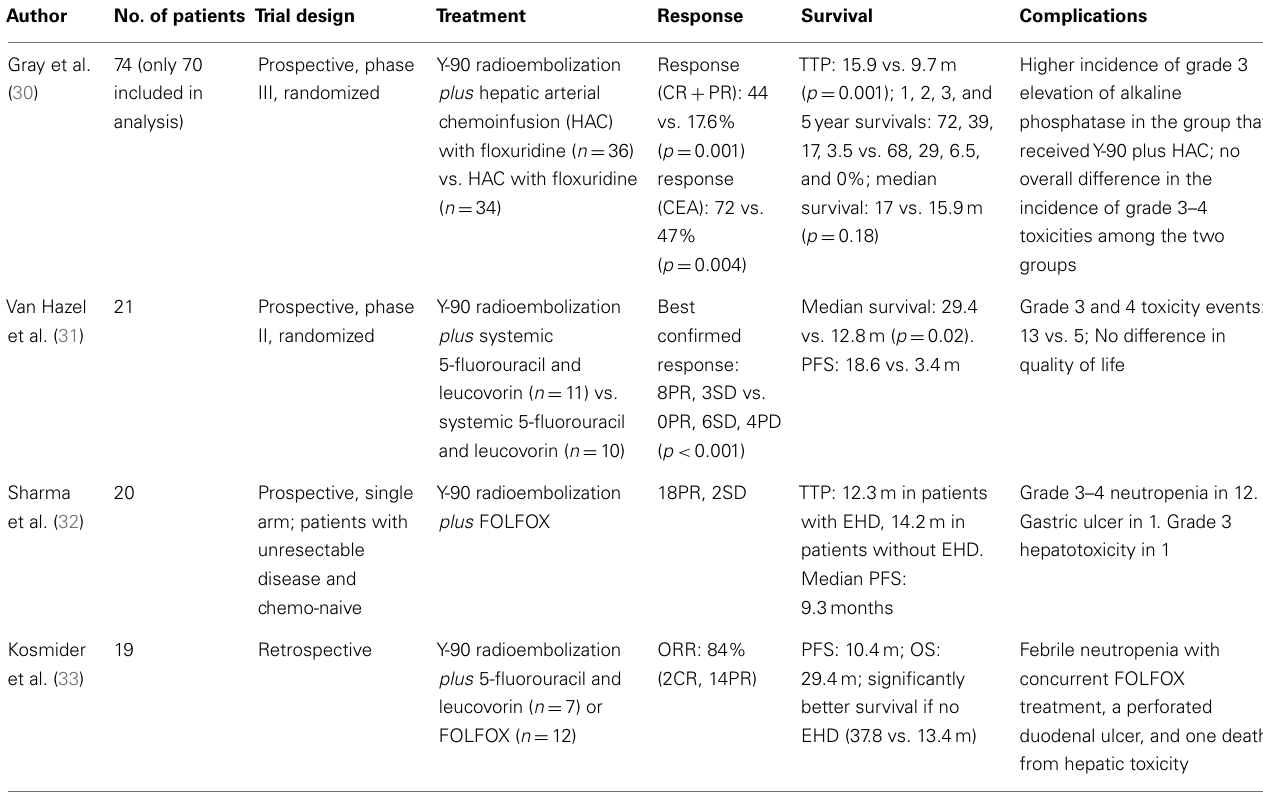
FIGURE 2 |Assessment of response toY-90 therapy on CT . A contrast enhanced CT scan (A) of the liver demonstrates hypo-attenuating lesions (arrows) in the liver. A repeat contrast enhanced CT scan (B) obtained 6weeks